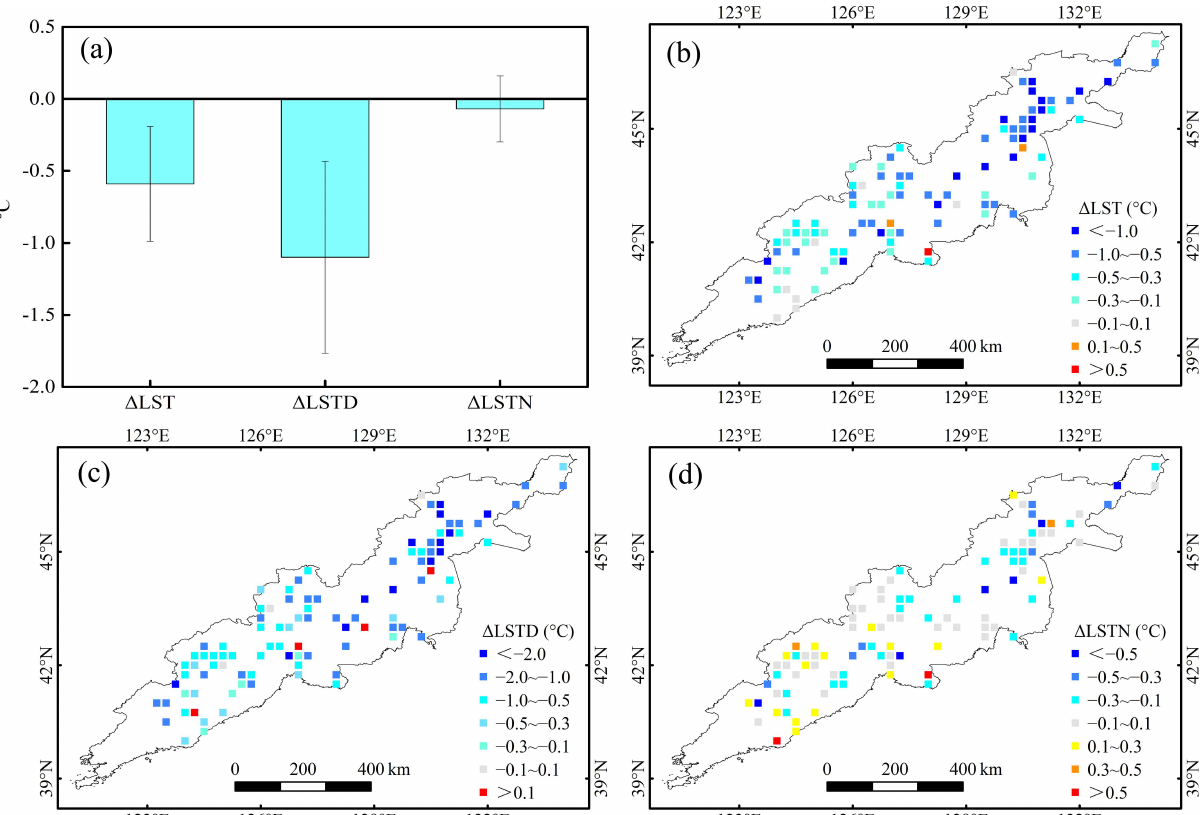
Figure 3. Regional average ( a ) and spatial distribution of differences in summer average surface temperature ( ∆ LST, ◦ C) ( b ), daytime surface temperature ( ∆ LSTD, ◦ C) ( c ), and nighttime surface temperature ( ∆ LSTN, ◦ C) ( d ) between forest and open land in Changbai Mountain from 2003 to